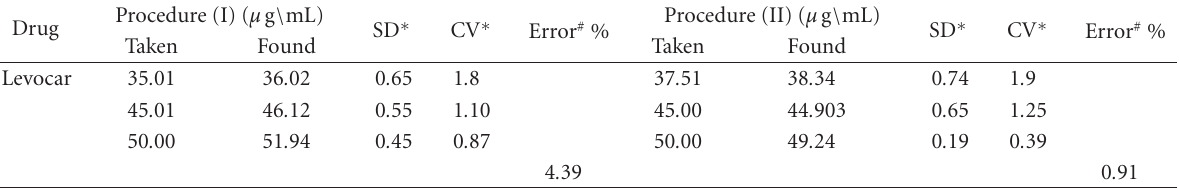
Table 4. Microdetermination of LD in pharmaceutical form using copper (II) complex and 4-AAP and LD with I − 3 .